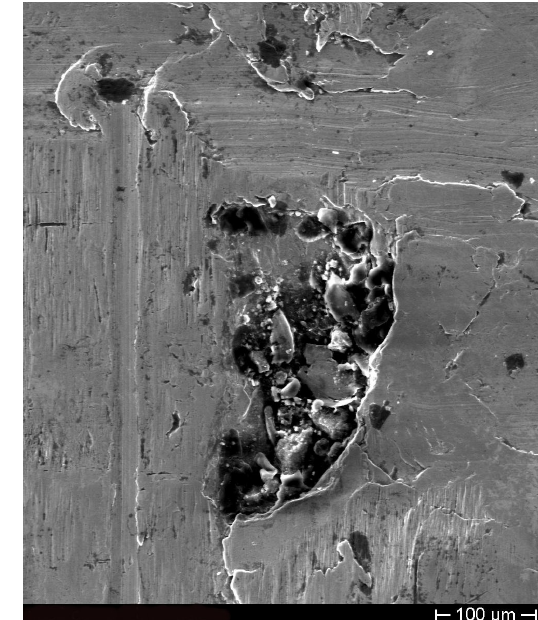
Figure 12: SEM micrograph of the scored area found in the central part of the piston (sample